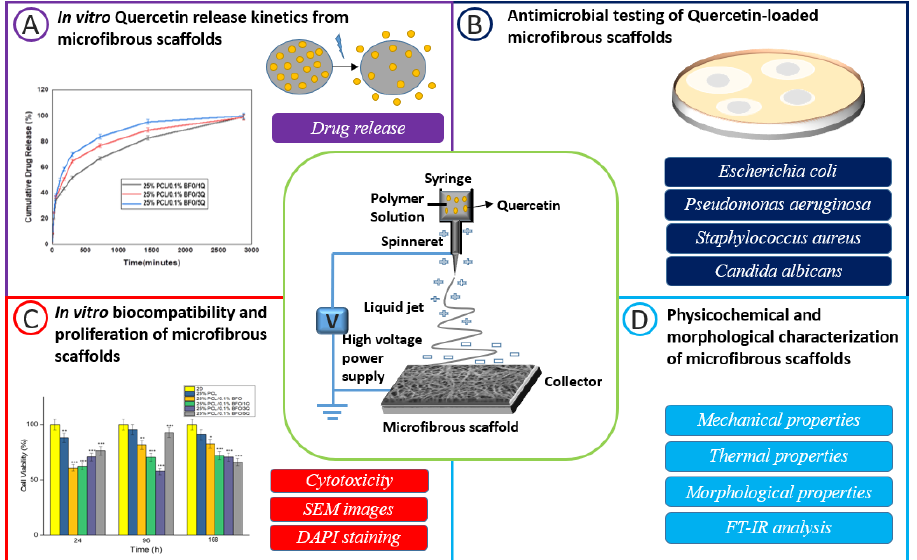
Figure 1. Graphical abstract illustrating the characterization and fabrication of the microfibrous scaffolds. In vitro release of Q from microfibrous scaffolds ( A ). Antimicrobial testing of Q-loaded microfibrous scaffolds ( B ). In vitro biocompatibility and proliferation of microfibrous scaffolds as- sessed by cytotoxicity test, SEM, and DAPI staining. Significance levels are indicated by * p < 0.05, ** p < 0.01, and *** p < 0.001 ( C ). Physicochemical and morphological characterization of microfibrous scaffolds ( D